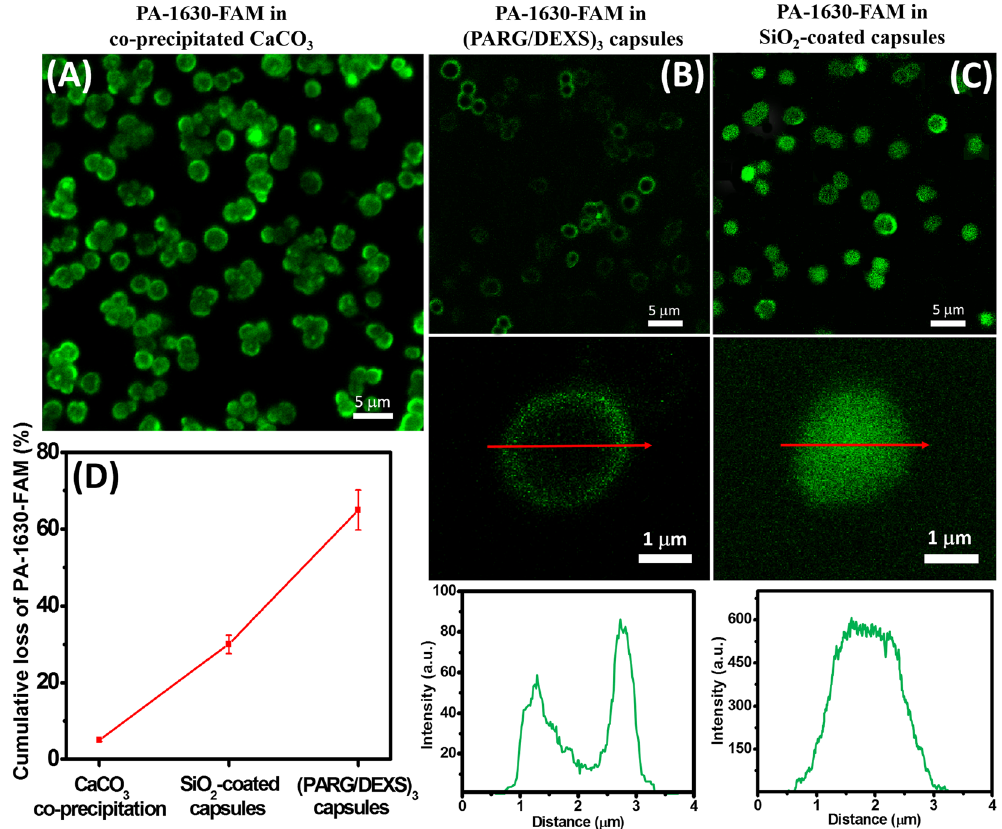
Figure 3. Confocal microscopy analysis of distribution of PA-1630-FAM in used carriers: ( A ) CaCO 3 microparticles; ( B ) (PARG/DEXS) 3 capsules; ( C ) SiO 2 -coated capsules. The plots below CLSM images are the representative fluorescence intensity profiles over the microcapsule. ( D ) Cumulative loss of PA-1630-FAM after dissolution of CaCO 3 in SiO 2 -coated and (PARG/DEXS) 3 capsules,